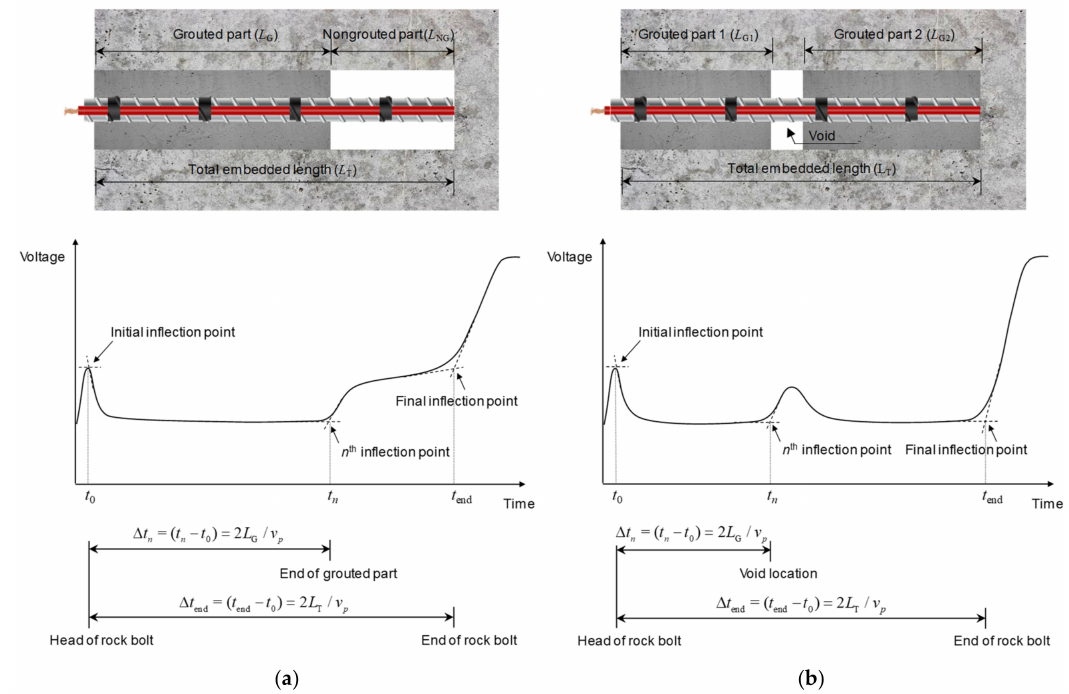
Figure 5. Waveforms of electromagnetic waves in defective rock bolts with: ( a ) non-grouted part at the end; ( b )